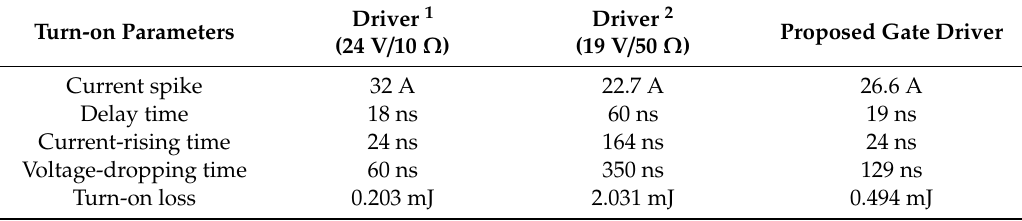
Table 6. Experimental results of the turn-on process based on different gate drivers.